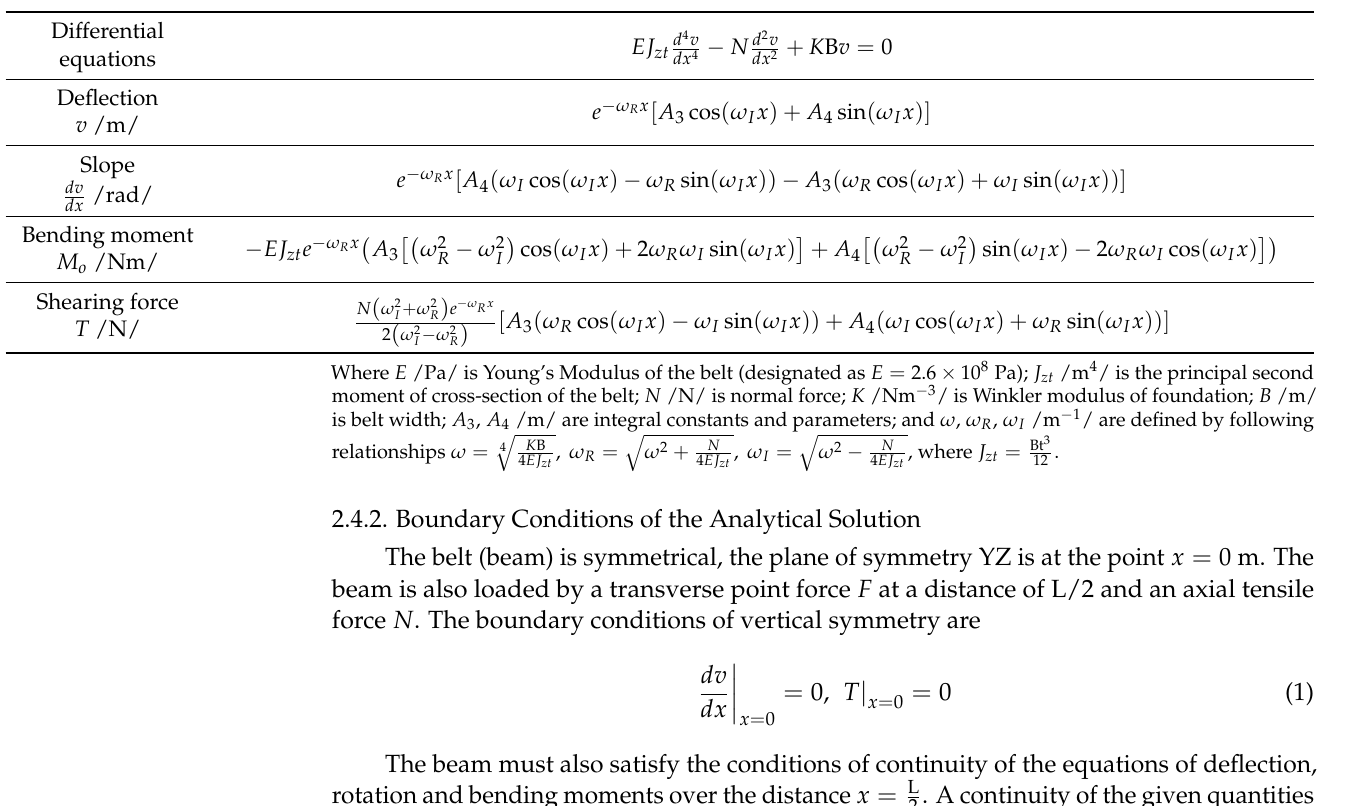
Table 1. General solution of an infinite beam on an elastic foundation for 𝑥 ∈ ⟨0;∞)